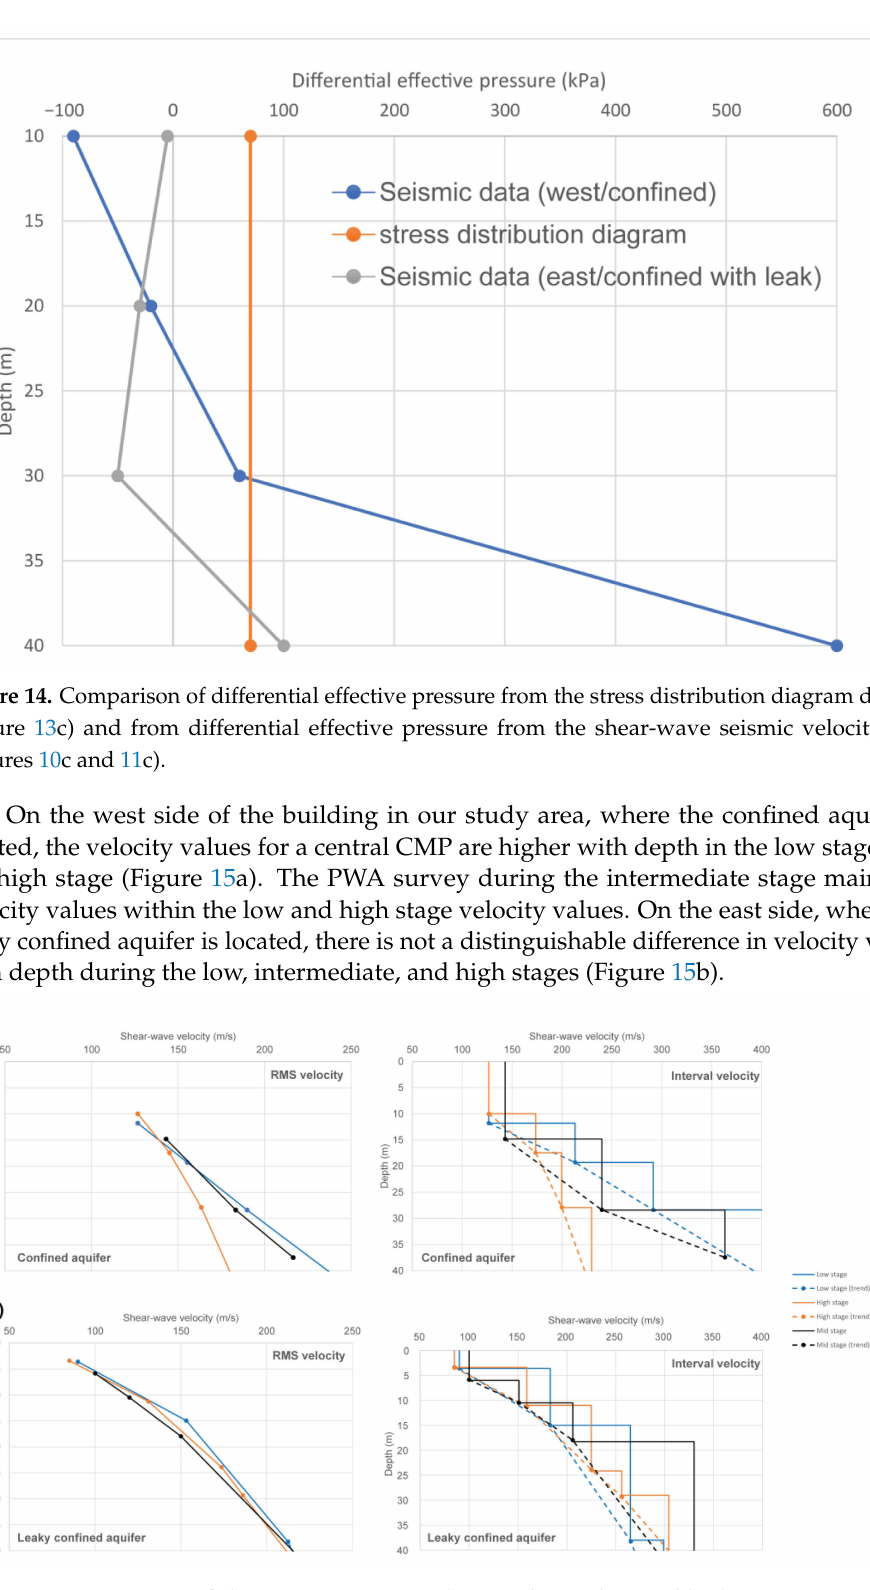
Figure 15. Comparison of shear-wave seismic velocities during low and high river stages using a central CMP and during mid-river stage using the PWA data on ( a ) the east side of Vet. School (25 m from levee toe) and ( b ) west side (355 m from levee